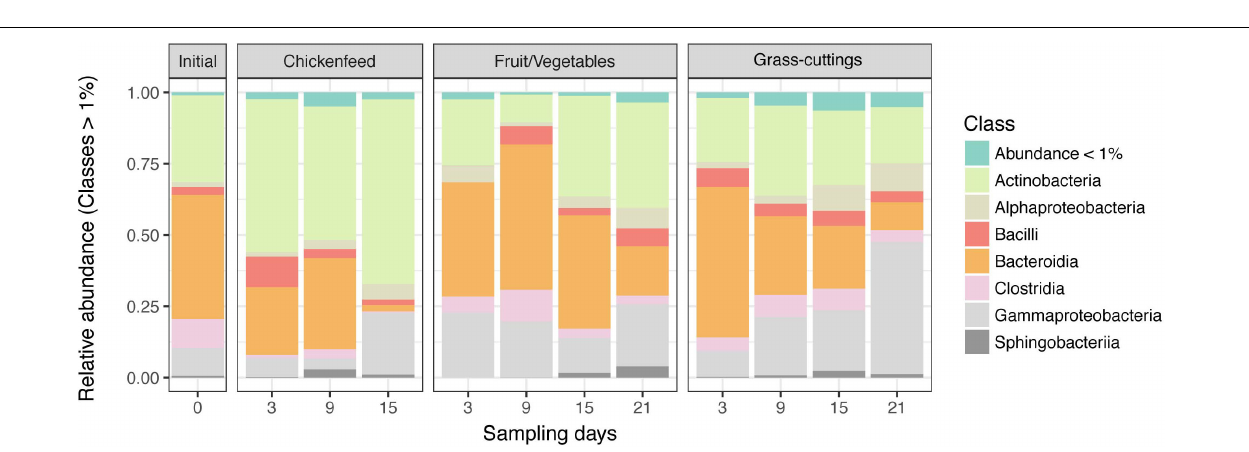
FIGURE 4 | Chao1 species richness (A) and Shannon diversity index (B) of bacterial gut communities over time ( n = 3). The lower and upper limitations of each box define the 25th and 75th percentile and the median is represented by the black lines. Labels on the x -axis describe the treatment (IP = initial population, CF = chickenfeed, FV = fruit/vegetable mix, GC = grass-cuttings) and the day of sample collection (0–21) (e.g., IP0 = gut samples from the initial population collected at t 0 ).